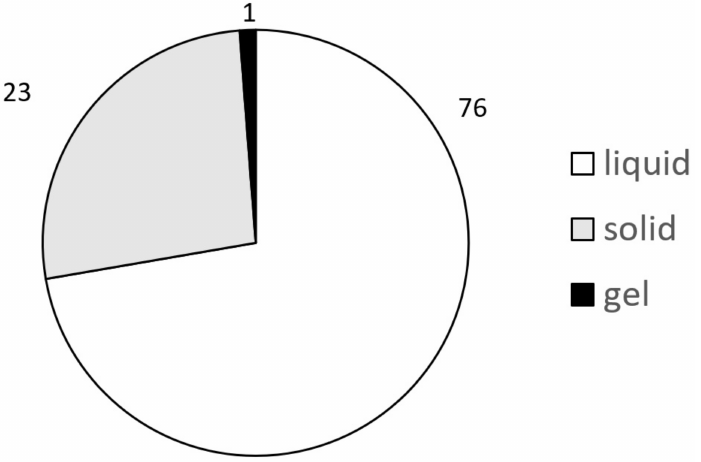
Figure 3. Composition of 100 reference chemicals in ChemSkin DB Pie chart of 100 chemicals classified by physical